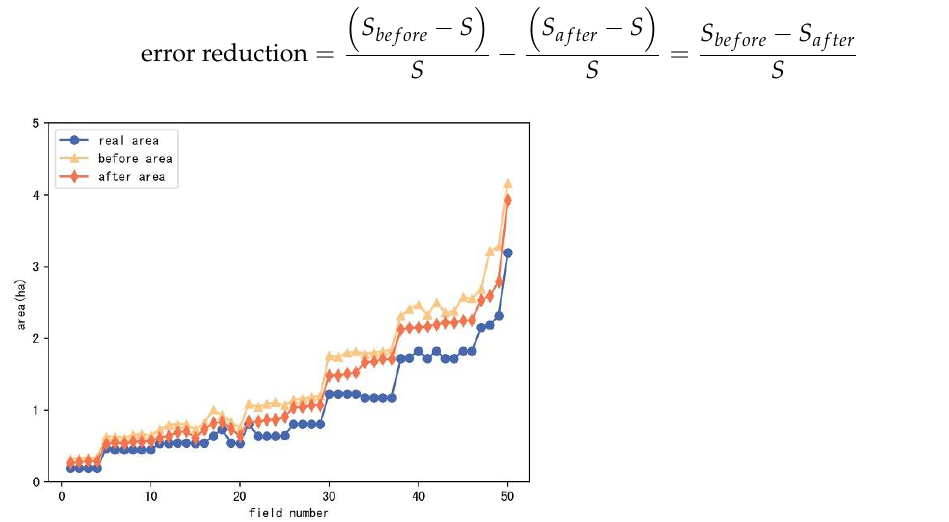
Figure 6. The real area, the calculated area before processing, and the calculated area after processing